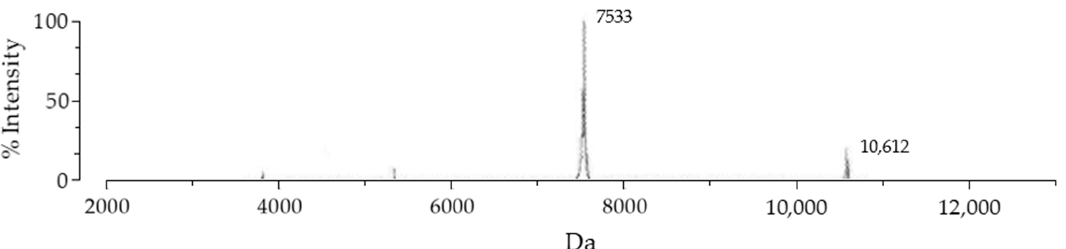
Figure 3. Tricine SDS-PAGE (15%) analysis of SmbP_BmK-AGAP and rBmK-AGAP purification. Lane 1: protein marker; Lane 2: cell lysate; Lane 3: flowthrough; Lane 4: SmbP_BmK-AGAP after IMAC purification; Lane 5: rBmK-AGAP after enterokinase digestion and a second round of IMAC (calculated molecular weight: 7.54 kDa); Lane 6: free SmbP after enterokinase digestion (calculated Figure 4. MALDI-TOF MS spectrum of the rBmK-AGAP peptide. After the second purification molecular weight 10.7 kDa). step, the peptide was analyzed with the VITEK MS (BIOMERIEUX) mass spectrometer using α - Cyano-4-hydroxycinnamic acid as the matrix. The 7533 peak coincided with rBmK-AGAP, while the 10,612 value corresponded to free SmbP present in the